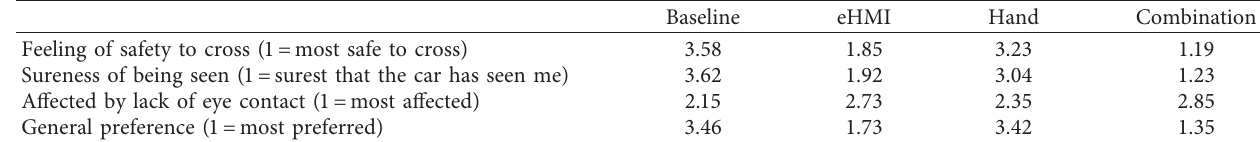
Table 2: Mean rank when sorting the four experimental conditions ( n � 26). Baseline eHMI Hand